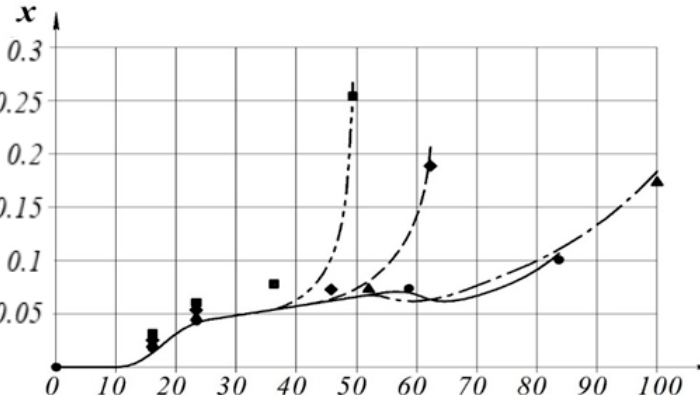
Figure 7. Distribution of mass content vapors along the length of the LVE flow path. Results of